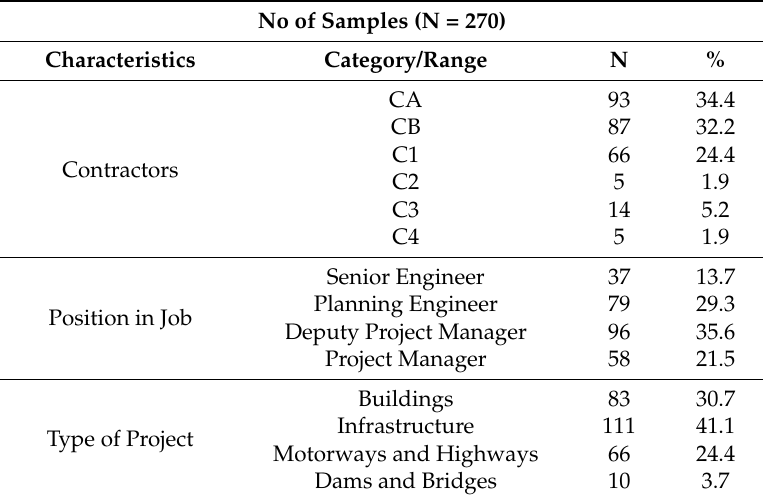
Table 2. Profile of Companies, Respondents, and